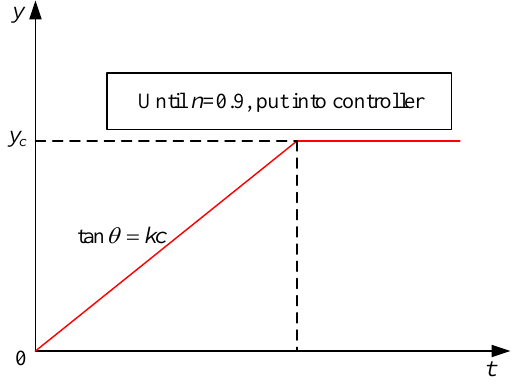
Figure 12. Schematic diagram of guide vane opening change